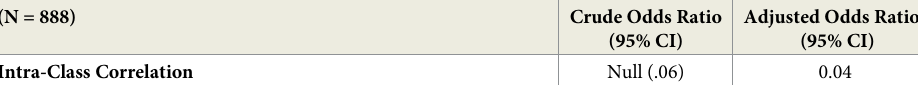
0.27) as compared with infants less than three months of age Table 4. The ICC for the AOR model was 0.18, indicating that there was a stronger clustering effect at the Anganwadi level among the monitored participants data as compared with the community-based sample.